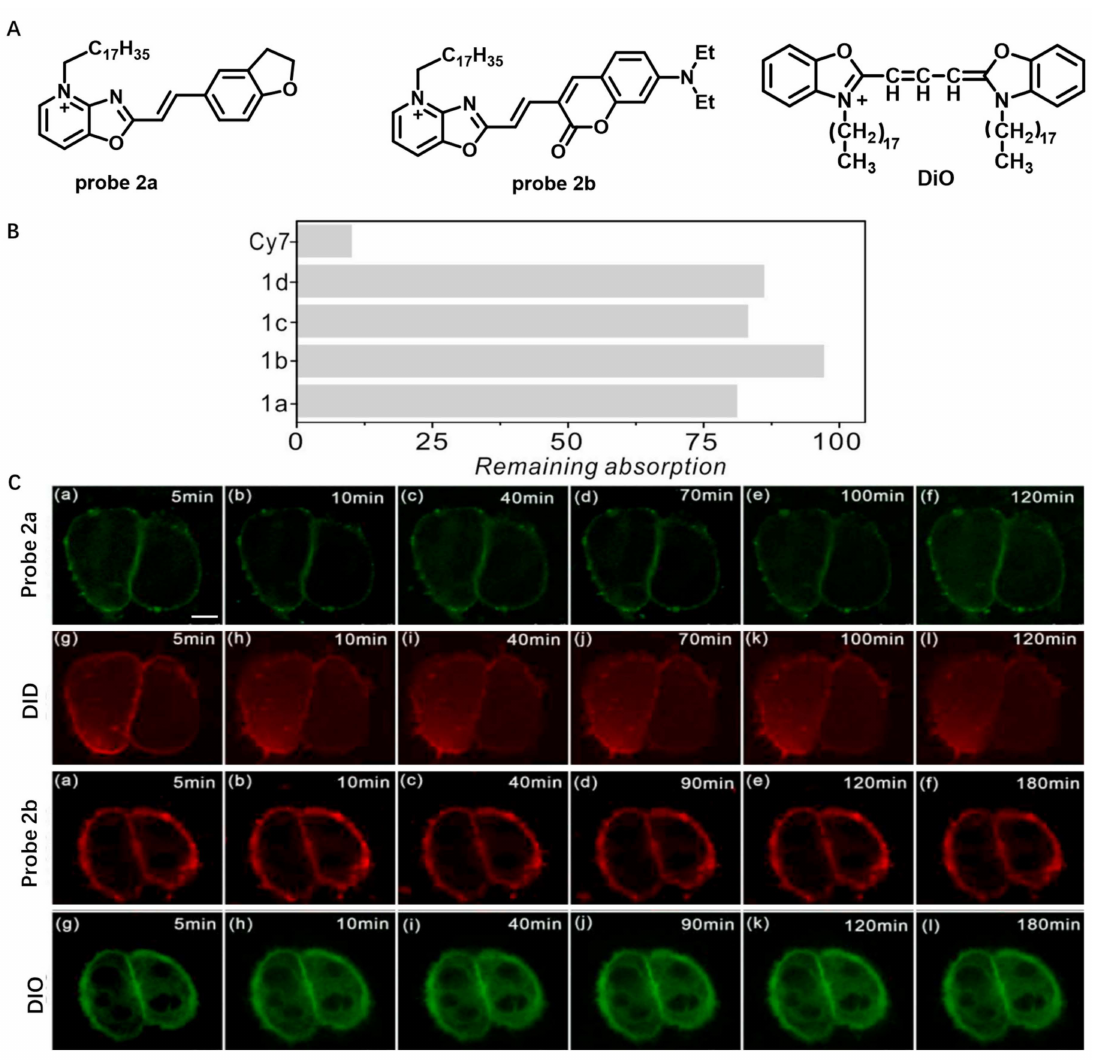
Figure 2. ( A ) Chemical structures of probe 2a and 2b and DiO. ( B ) The photostability of probes 2a , 2b and Cy7 in acetonitrile. ( C ) Long-term imaging of HeLa CM using probes 2a , 2b , DiD and DiO. Scale bar: 10 µ m. Copyright 2021 Elsevier